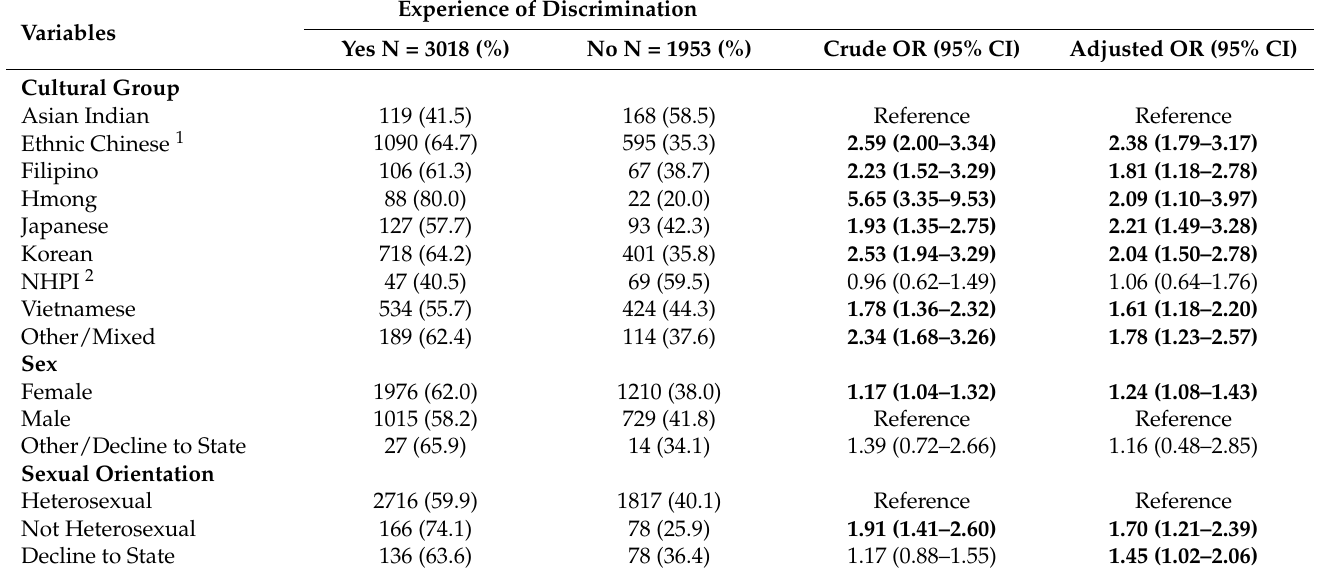
Table 3. Experiences of discrimination during the COVID-19 pandemic due to being Asian, Asian American or Pacific Islander by cultural group: N(%).